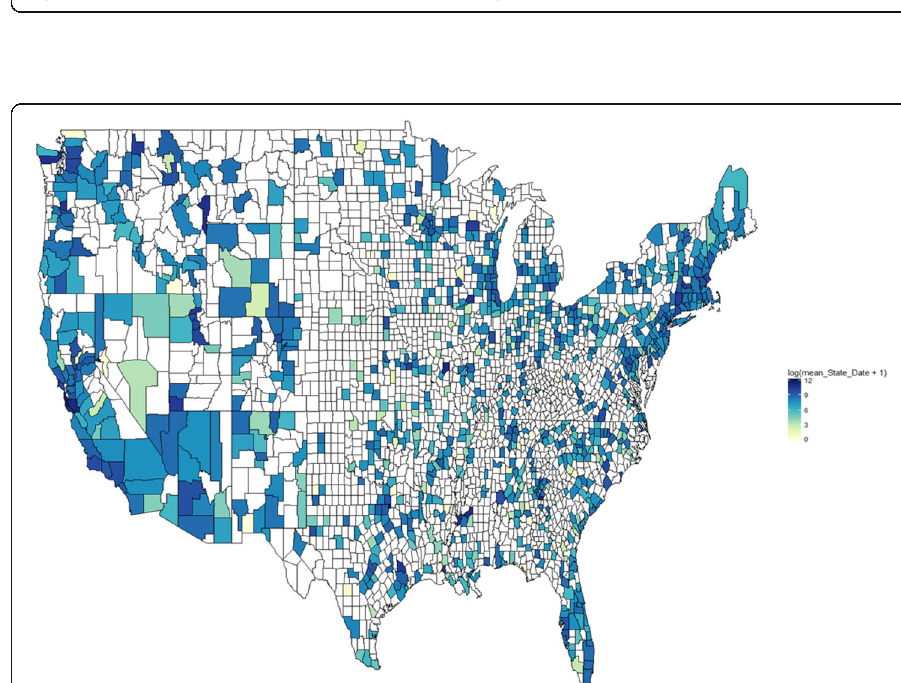
Fig. 8 Map of county map showing the mean pledges USD per